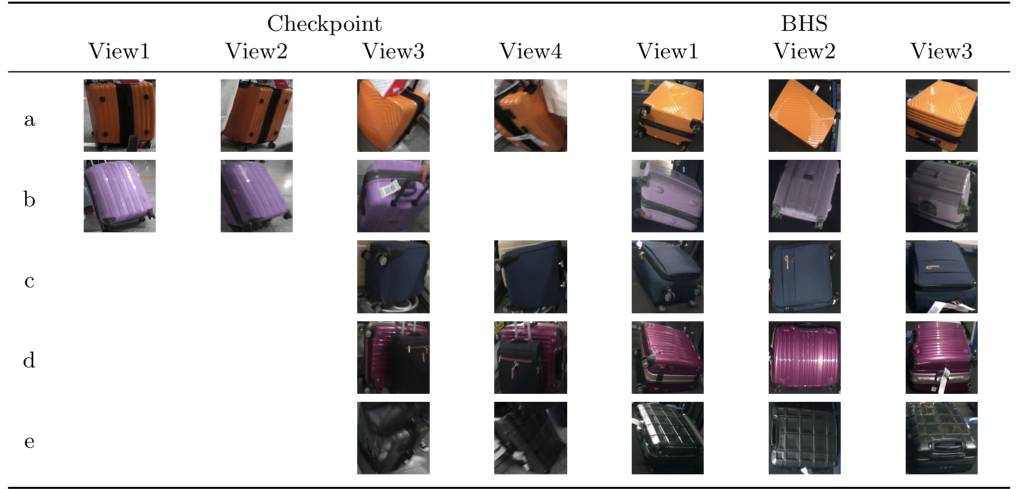
Figure 7. Samples of intra-class dissimilarity on MVB. Blank cell indicates corresponding view image is not valid. Images in each row represent the same identity. ( a ) images containing different viewpoint and pose; ( b ) images taken with different lighting conditions; ( c , d ) images with different occlusions; ( e ) images blurred for passenger motion